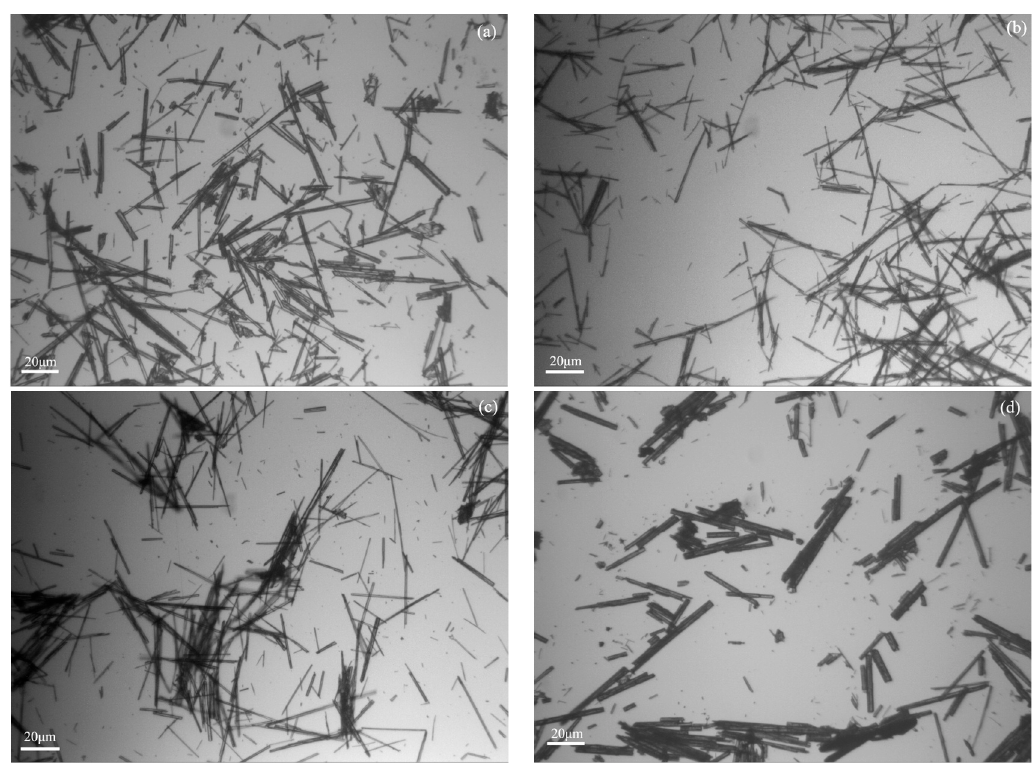
Figure 1. Images of the synthesized products ( a ) without additives and in the presence of ( b ) sodium oleate, ( c ) sodium dodecyl benzene sulfonate (SDBS), and ( d ) sodium citrate.